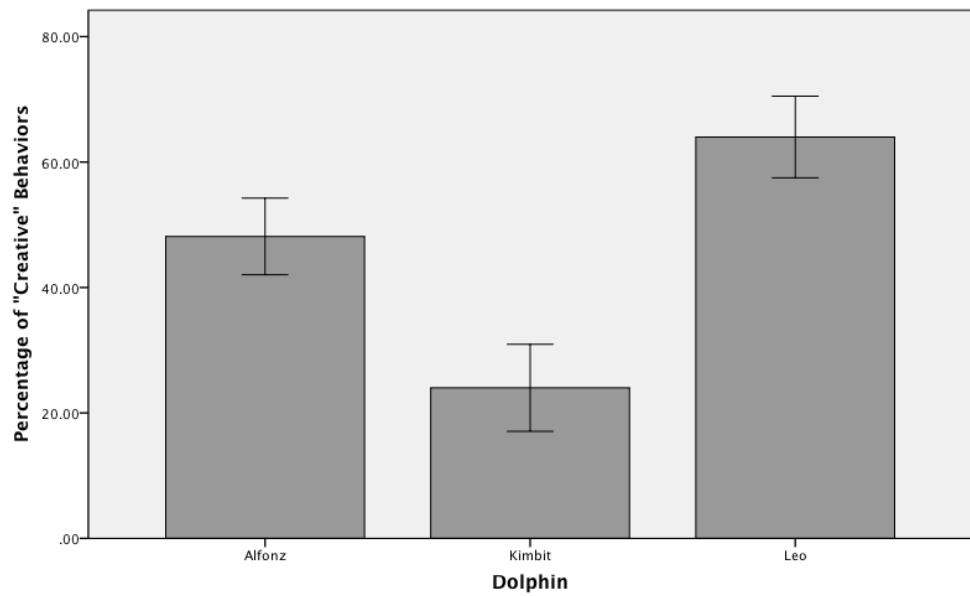
Figure 6. Mean percentage of “creative” behaviors produced by each